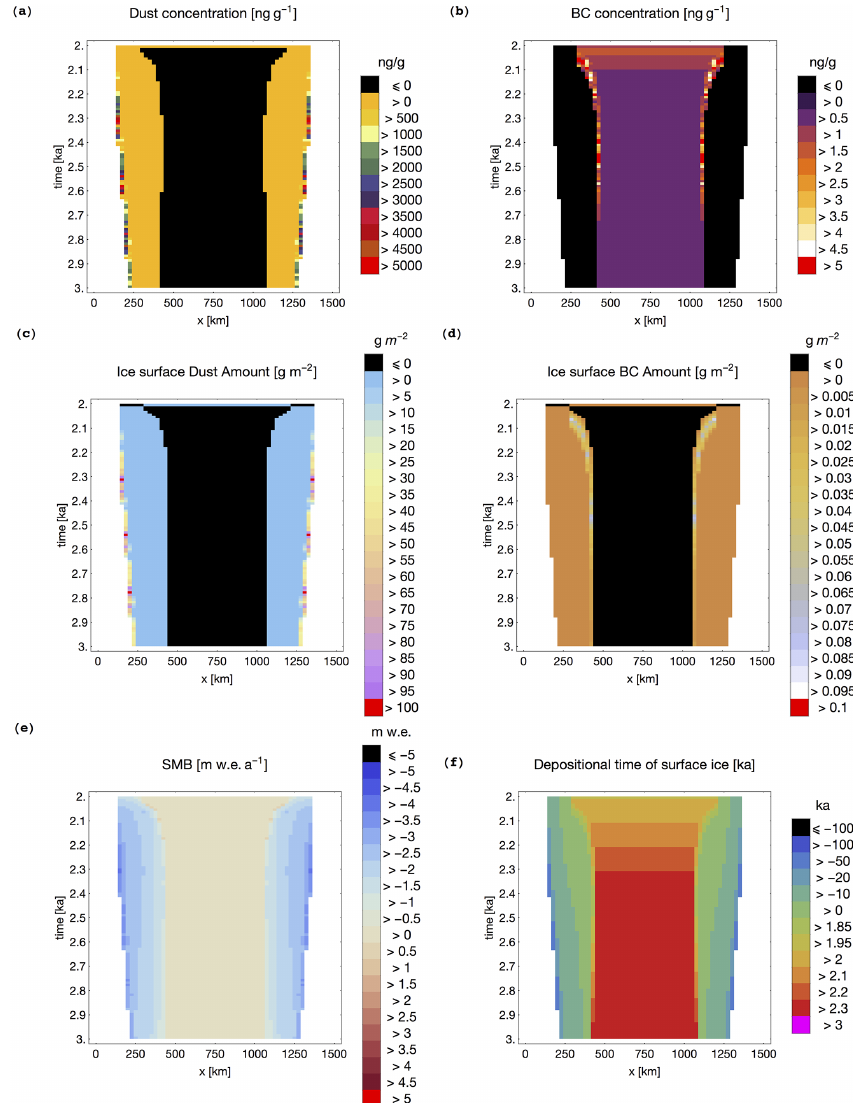
Figure 9. Time series of the RCP 4.5 scenario including aerosols: (a) englacial dust, (b) BC concentrations, ( c and d ) respective surface amount on 1 August, (e) surface mass balance and (f) depositional time of ice at the